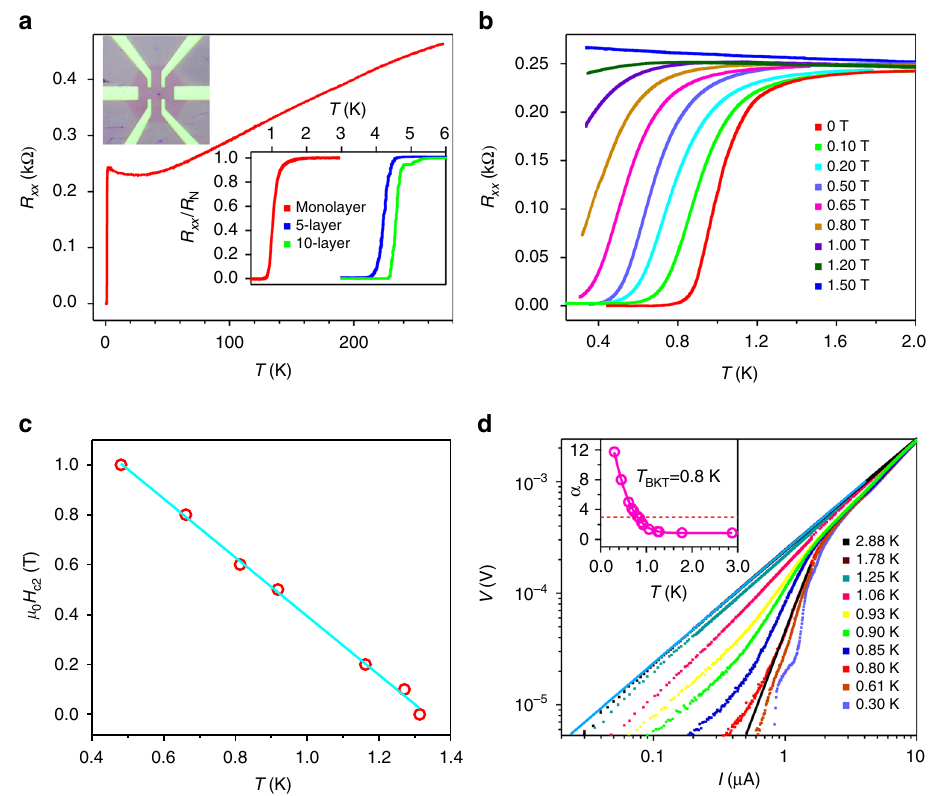
Fig. 4 Superconductivity in monolayer NbSe 2 devices. a Temperature dependence of the longitudinal resistance R xx for sample A — a monolayer NbSe 2 device. Upper left inset : Optical image of a typical graphene protected monolayer NbSe 2 device. Lower right inset : Superconductivity in monolayer, 5-layer and 10-layer NbSe 2 devices. b Superconductivity of sample A in different magnetic fi elds. c Temperature dependence of the upper critical fi eld H c2 . The solid line is the linear fi t to H c2 . d Voltage – current ( V - I ) characteristic at different temperatures on a logarithmic scale. The solid blue line indicates the Ohmic behavior at high temperature. The solid black line represents the expected V ∝ I 3 behavior at the Berezinskii-Kosterlitz-Thouless (BKT) transition. The inset shows the temperature-dependent exponent deduced from the power-law behavior, V ∝ I α . As indicated by the red dashed line , α approaches 3 at T = 0.8